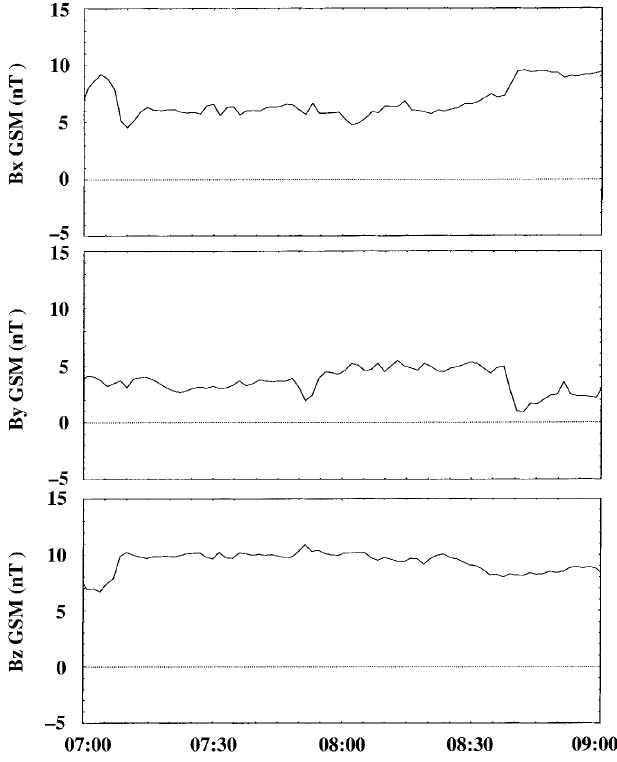
Fig. 1. Bx , By and Bz components of the interplanetary magnetic field intensity measured by the WIND satellite between 07 and 09 UT on 21